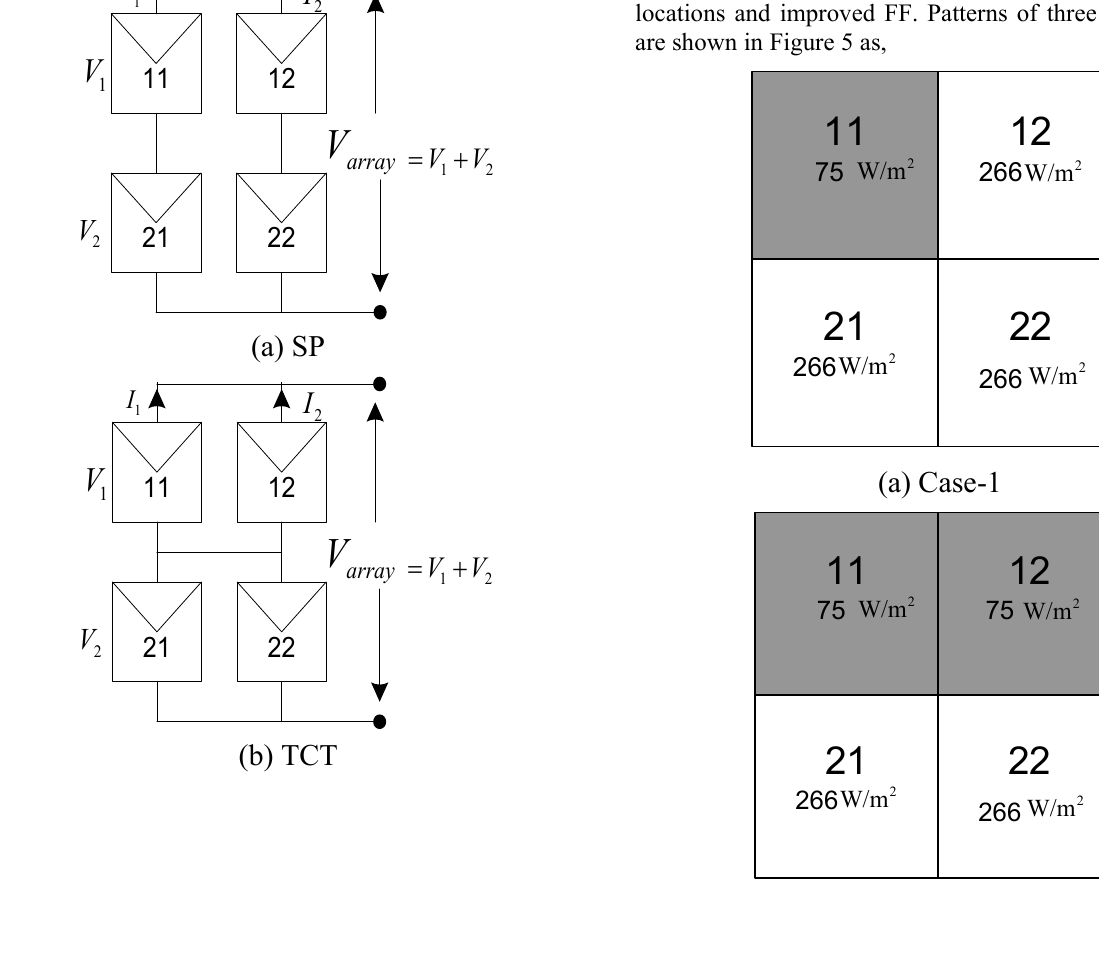
paper viz. First: single PV module-11 shaded; Second: two PV modules shaded- 11and 12; Third: three PV modules shaded- 11, 12 and 22 due to the movement of the sun or any type of obstruction. The article briefly reflects the impact of these considered all shadow cases-1, 2, 3 on solar PV performance in terms of minimum power losses,